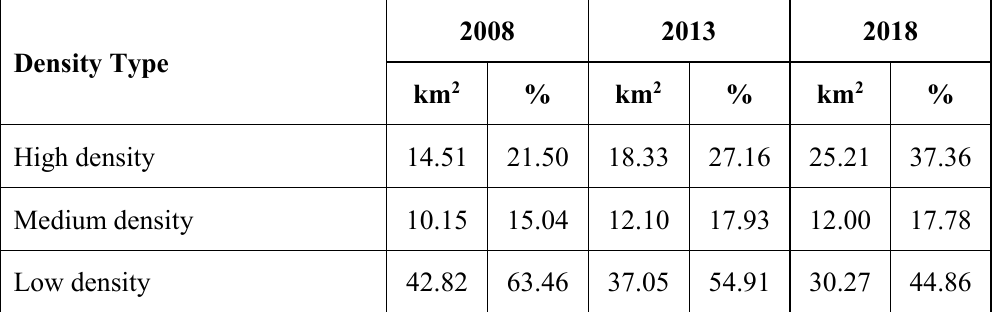
Table 1. Residential Density Changes for 2008, 2013 and 2018 (Developed by the authors, 2020)